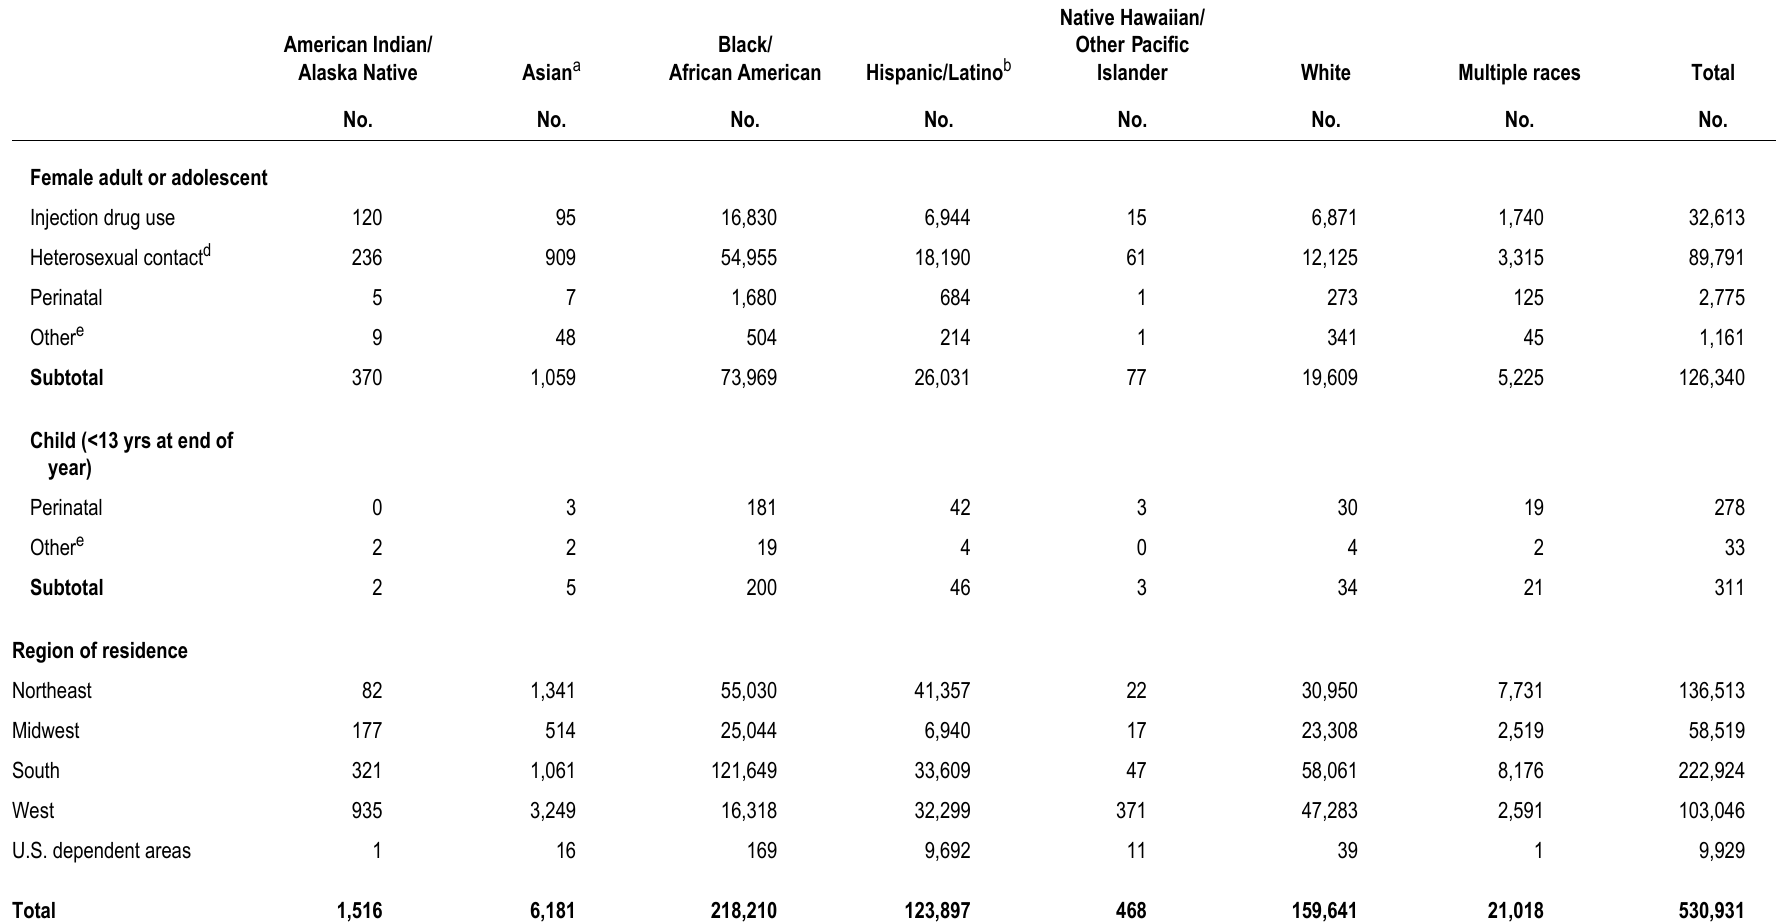
Table 21b. Persons living with diagnosed HIV infection ever classified as stage 3 (AIDS), by race/ethnicity and selected characteristics, year-end 2014—United States and 6 dependent areas